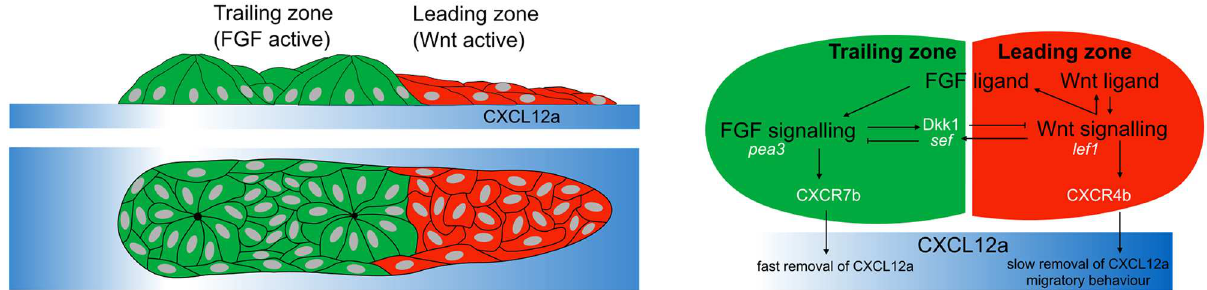
Fig 1. The geometry and signaling of the posterior lateral line primordium (PLLP). Left: A sketch of the PLLP showingside and top- down views, with leading (red) and trailing(green)cells on a stripe of CXCL12a.Right: A schematic diagram of signallingin the PLLP, showingthe mutual inhibitionbetweenFGFR and WntR signalling.(Black text denotesmodel components, white text aides in interpretation of experiments.) FGF signaling inhibits Wnt signalingby determining expressionof Dkk1; Wnt signalingcells express the gene sef that inhibits FGF signaling. WntR active cells are sources of both FGF and Wnt ligands. Experimentally, pea3 and lef1 expressionlevels are used to identify FGF and Wnt signalling,respectively. The WntR-FGFR activity polarization sets up chemokinepolarization(CXCR4b vs CXCR7b). In our model, this leads to the creationof a gradientof CXCL12athat enablesdirectedmigrationof the PLLP.